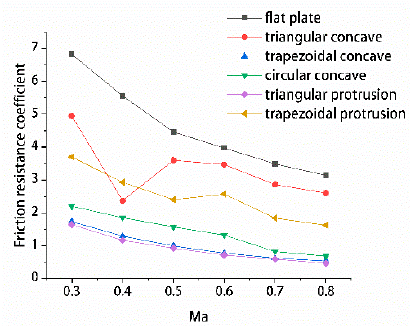
Figure 3. Friction resistance coefficient of different riblets and grooves varies with Mach number.